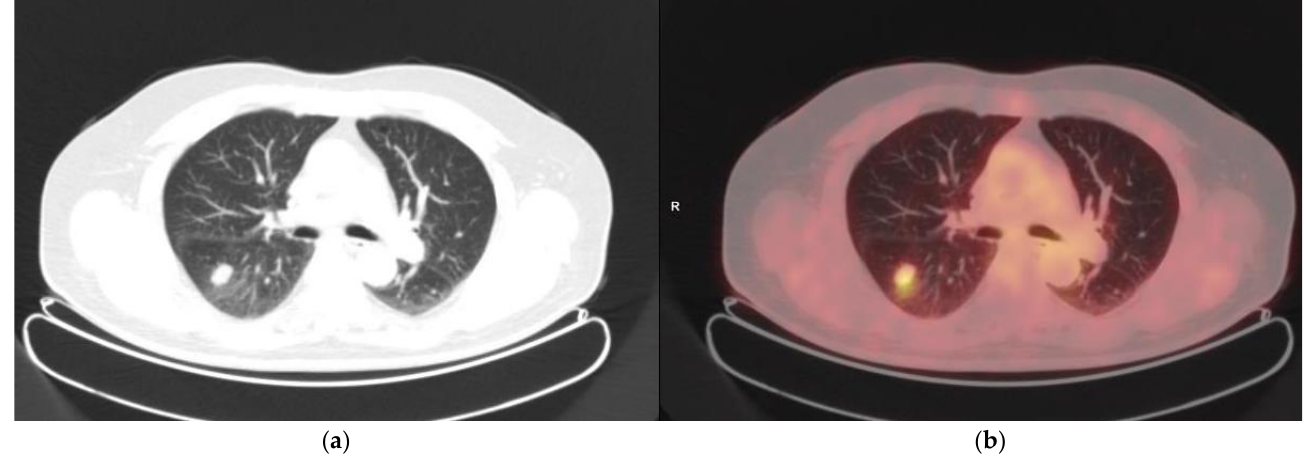
Figure 2. Classic KS. Hypermetabolic (SUVmax = 5) pulmonary nodule in inferior right lobe, con- firmed by histology. ( a ). CT axial slice; ( b ). Fused PET/CT axial slice.